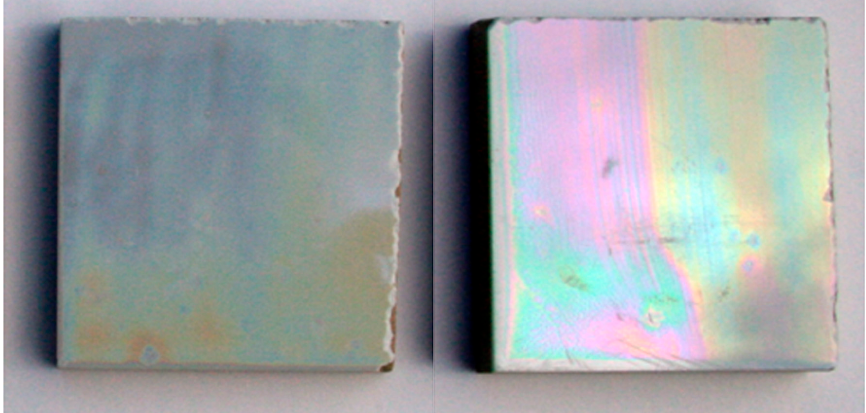
Figure 7. Samples of porcelain stoneware with zirconium oxide (ZrO 2 ) glaze and final glaze with anatasa (TiO 2 ).